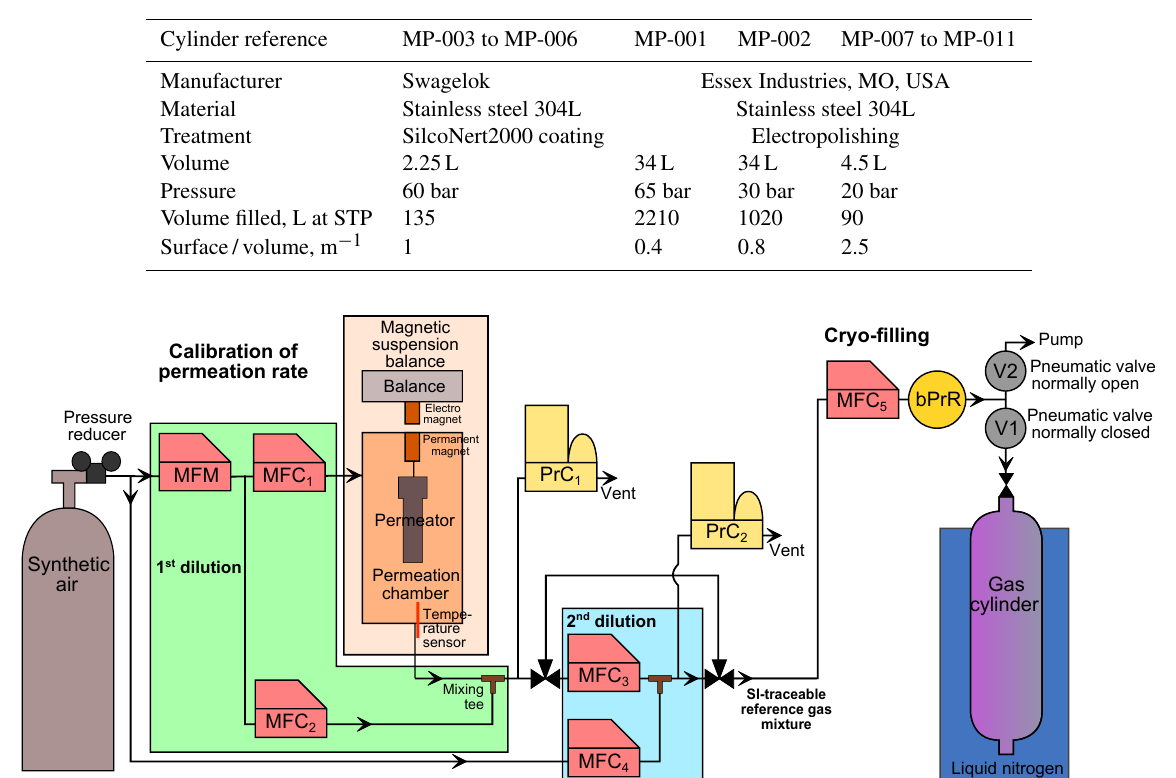
Figure 1. Schematic of the dynamic–gravimetric preparation method. MFM: thermal mass flow meter. MFC: thermal mass flow controller. PrC: pressure controller. bPrR: back (downstream) pressure regulator. V1 and V2: pneumatic